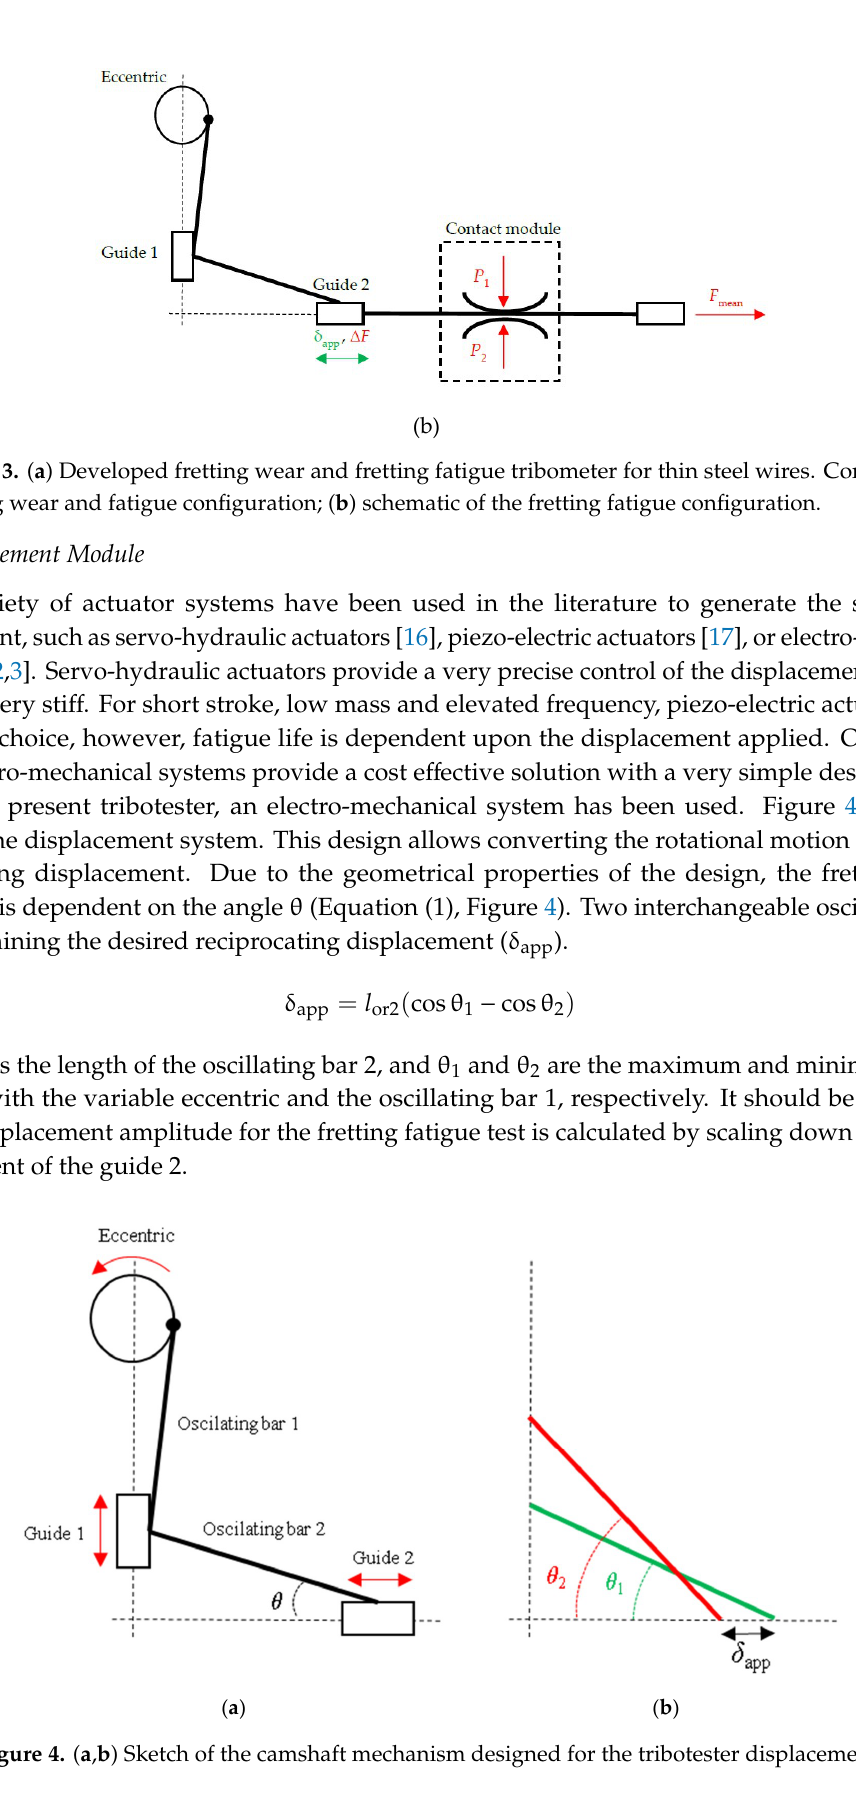
Figure 5. The contact module for fretting fatigue configuration.